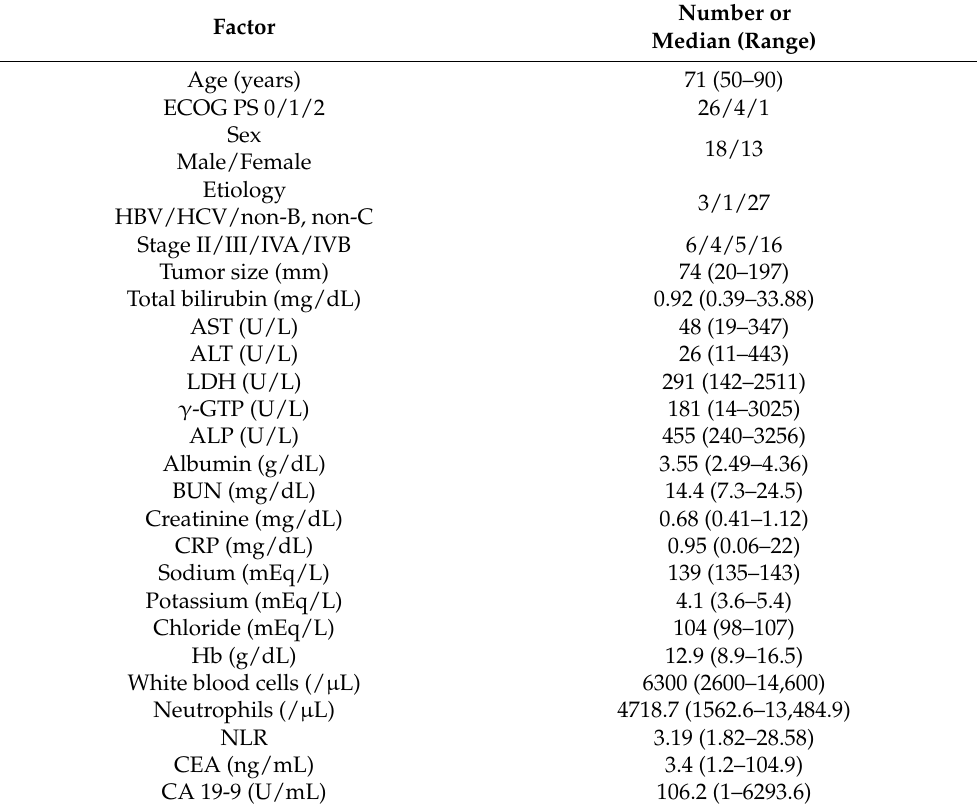
Table 1. Baseline characteristics of